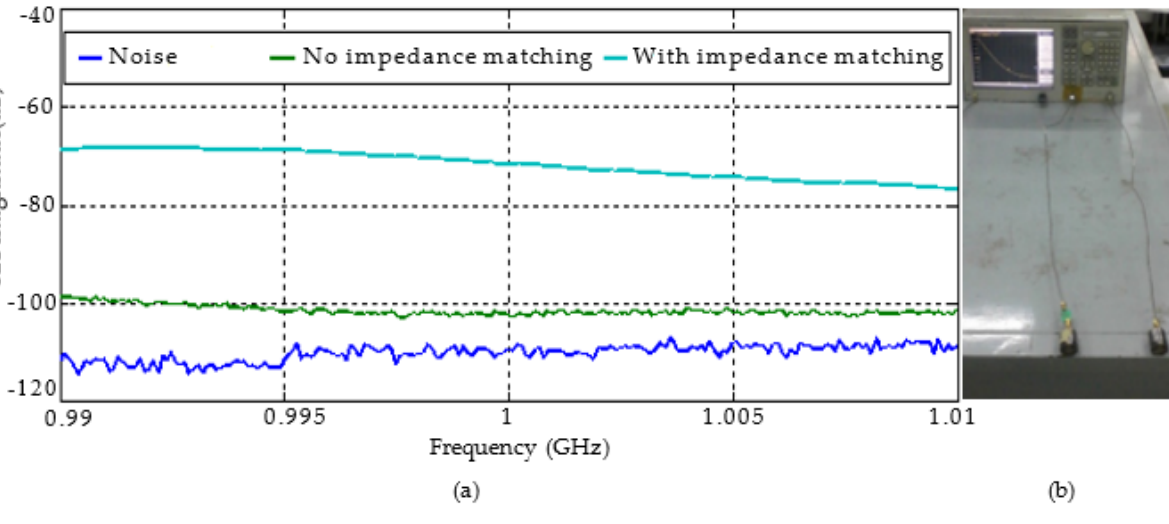
Figure 9. Actual measurement of transmission parameters of dual antennas: ( a ) measured curve of transmission parameters of dual antennas; ( b ) actual measurement diagram.